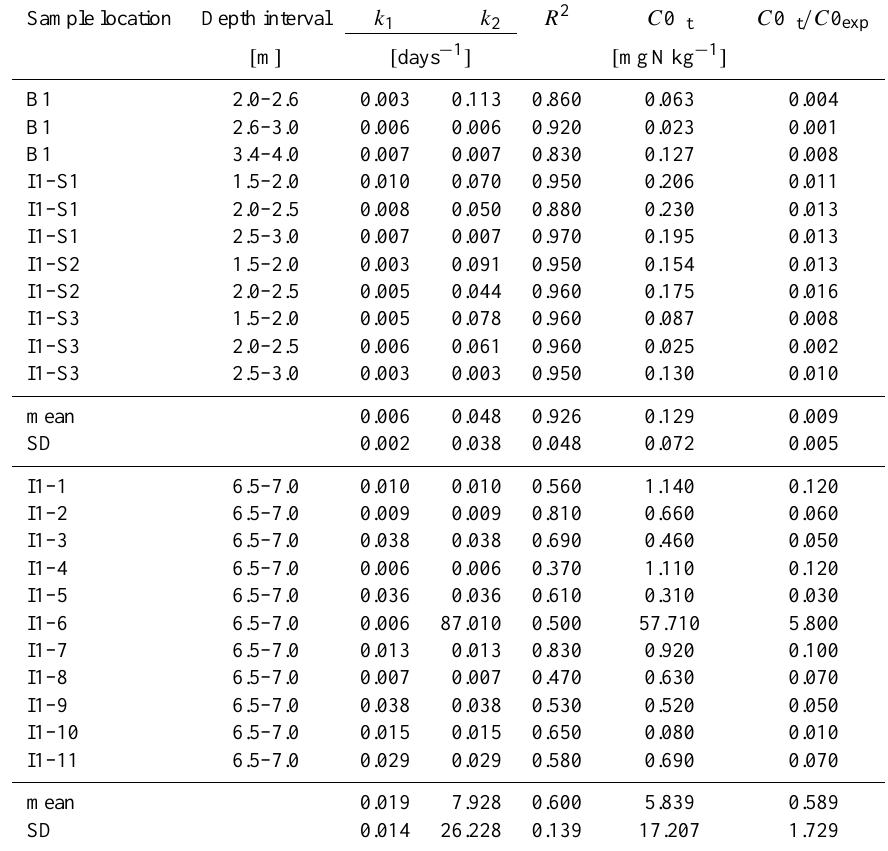
Table 5. Rate constants for heterotrophic and autotrophic denitrification derived from the 1-step 3-parameter fit. R 2 denotes the correlation coefficient.The initial nitrate concentration C 0 was used as third fitting parameter. The initial nitrate concentration C 0 was used as the third fitting parameter. The ratio of the fitting value and the experimental value is given in the last column and SD denotes the standard